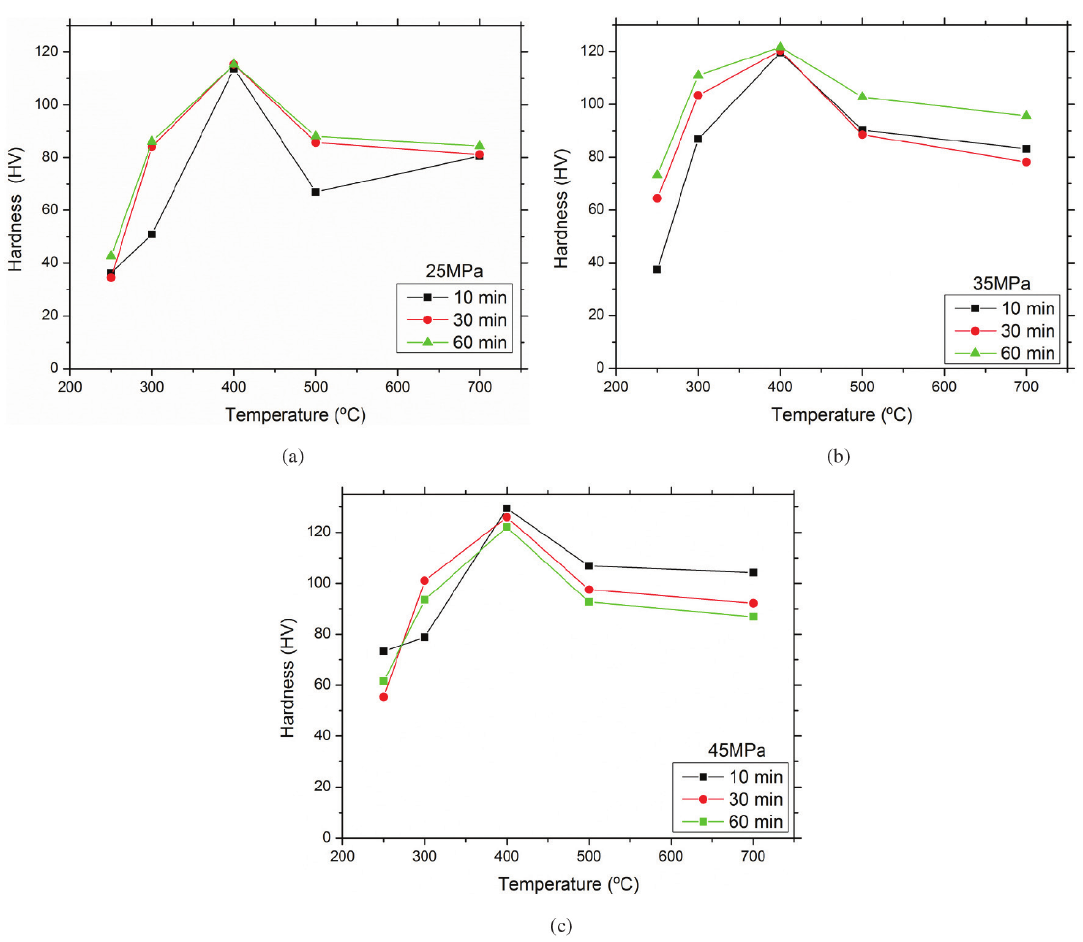
Figure 8. Influence of the processing parameters (pressure, time and temperature) on the hardness of the hot pressed sterling silver powder